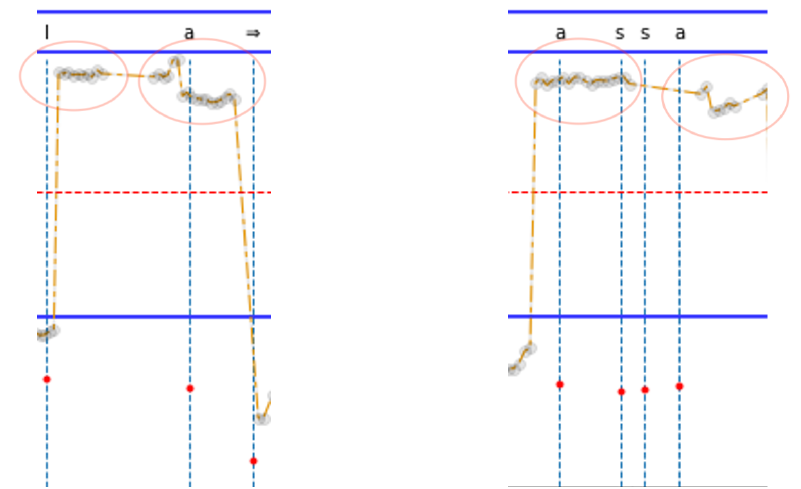
Figure 10. Example of gaze clusters in the upper area and missing gaze data between